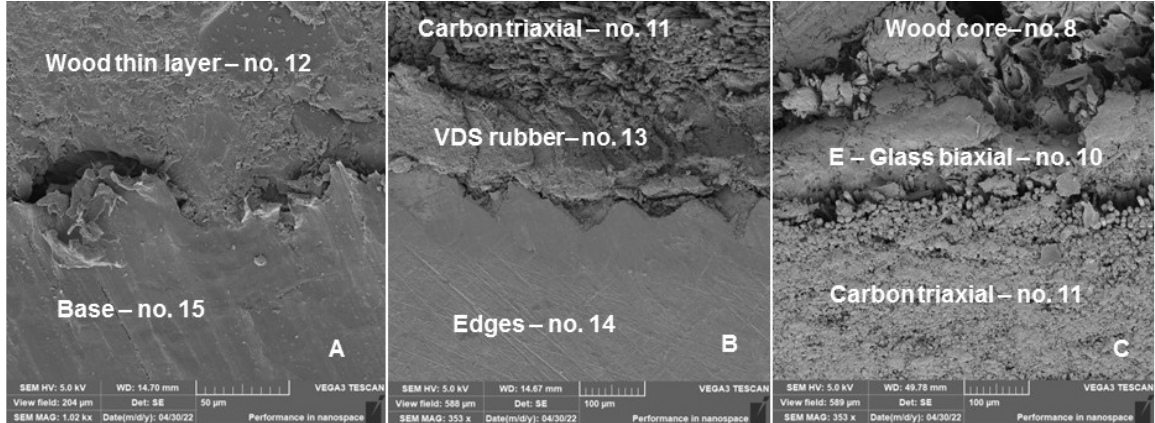
Figure 11. Cross-section of a hybrid sandwich ski structure after the end of long-term low-cycle fatigue, i.e., 70,000 cycles—SEM pictures: ( A ): Interaction of the base (No. 15) and wood thin layer (No. 12) interface—central part of the ski cross-section (MAG 1020×), ( B ): Interaction of the interfaces edges (No. 14), VDS rubber (No. 13) and carbon triaxial (No. 11)—extreme edge of the ski cross section (MAG 353×), ( C ): Interaction of the interfaces carbon triaxial (No. 11), E Glass biaxial (No. 10) and wood core (No. 8)—central part of the ski cross section (MAG 353×). The delamination was determined in the lower part of the tested ski at the interface between the wood sidewalls (No. 9) and carbon triaxial (No. 11) materials, i.e., the composite layer, see Figure 12.